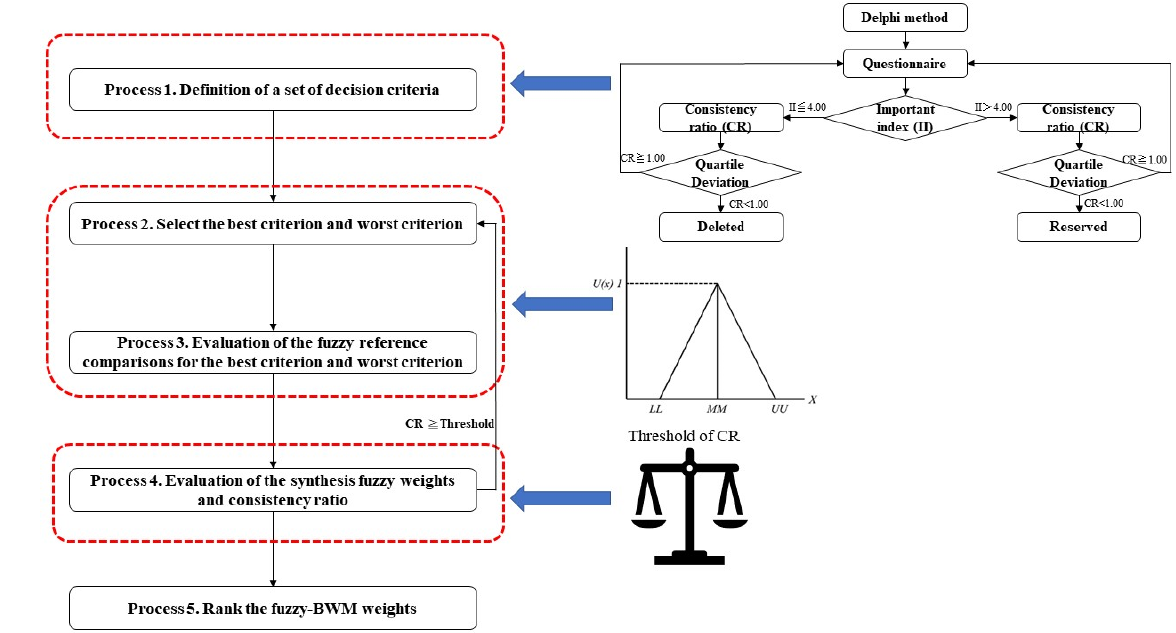
Figure 1. The evaluation processes.